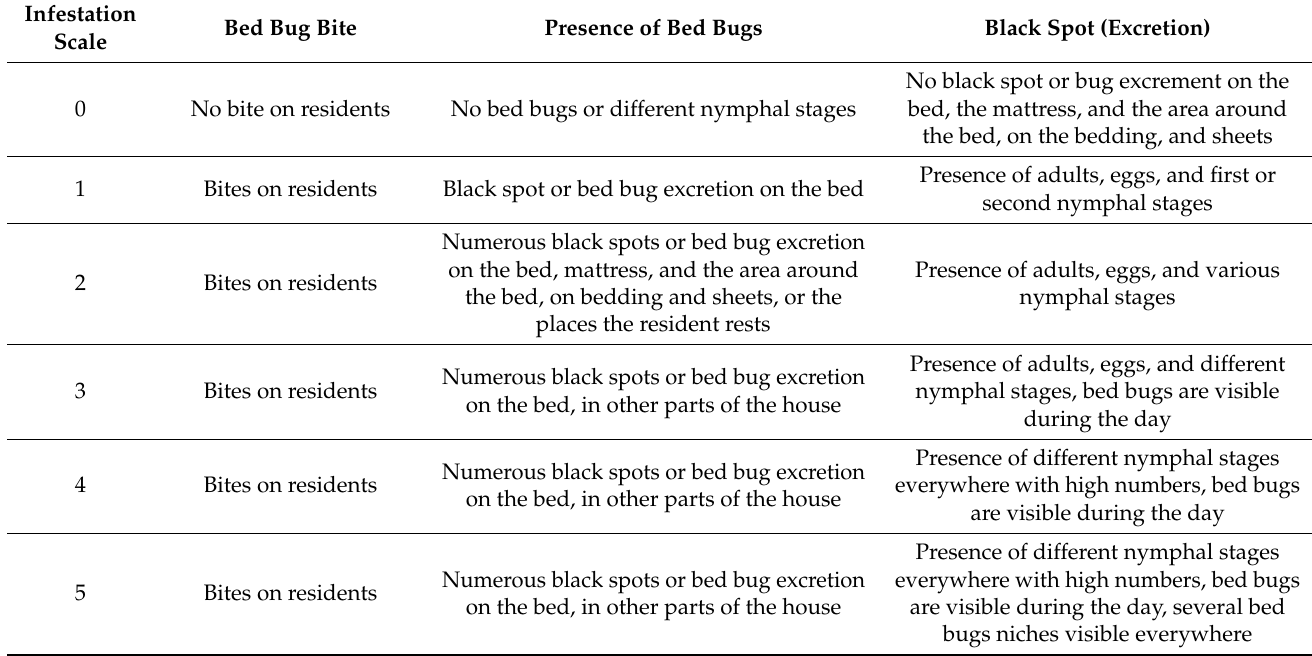
Table 1. Proposed infestation scale based on the signs observed by visual